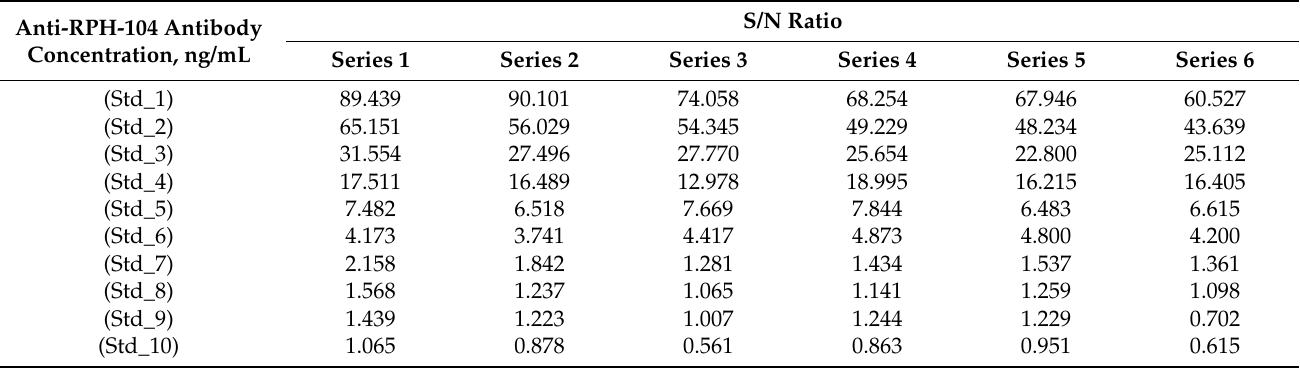
Table 5. S/N ratio calculated for all standards with various anti-RPH-104 antibody